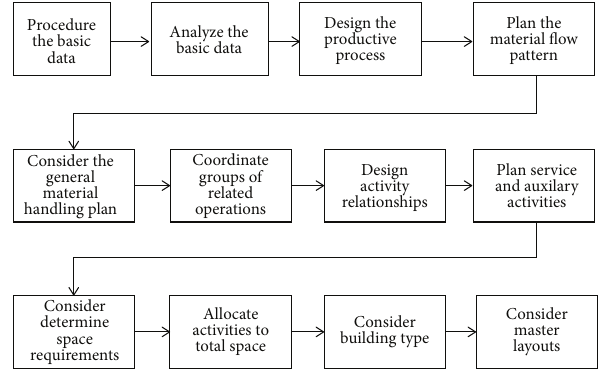
Figure 10. Flowchart for Apple’s layout